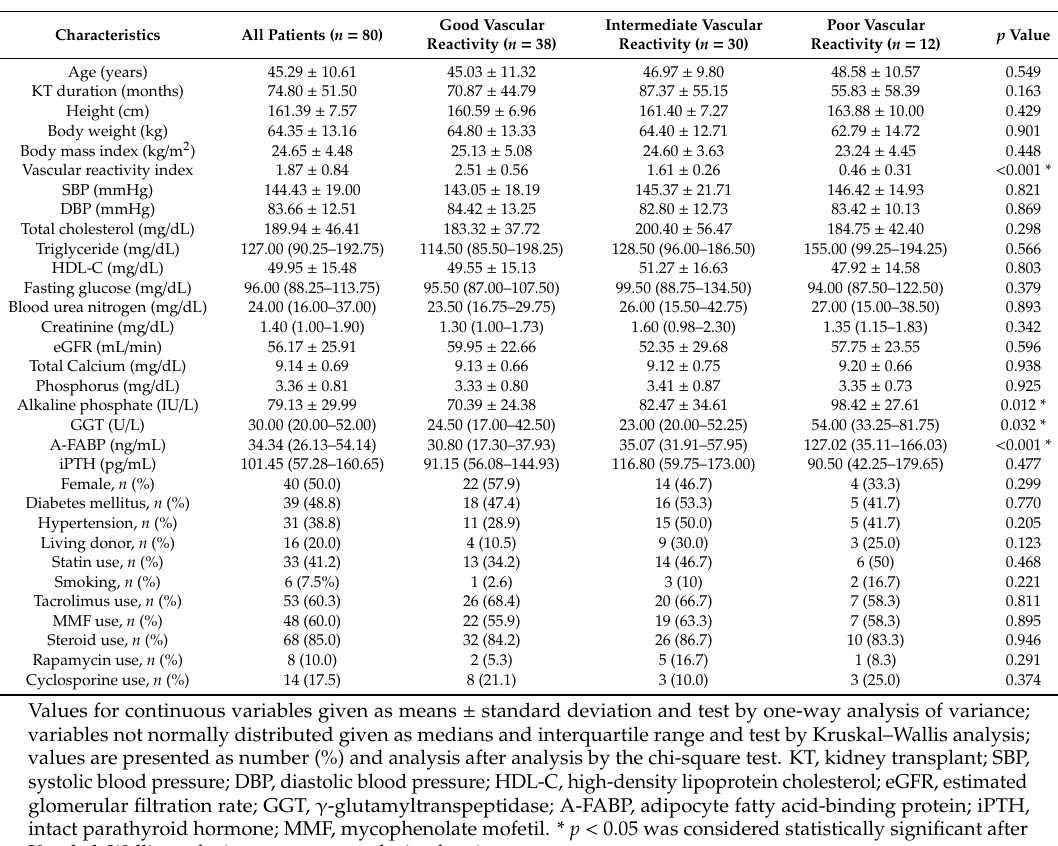
Table 1. Clinical characteristics according to di ff erent vascular reactivity index measured by digital thermal monitoring of 80 KT